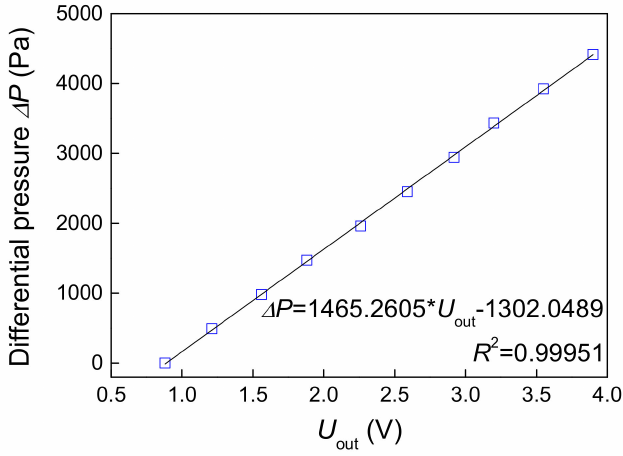
Figure 7. Calibration result of di ff erential pressure